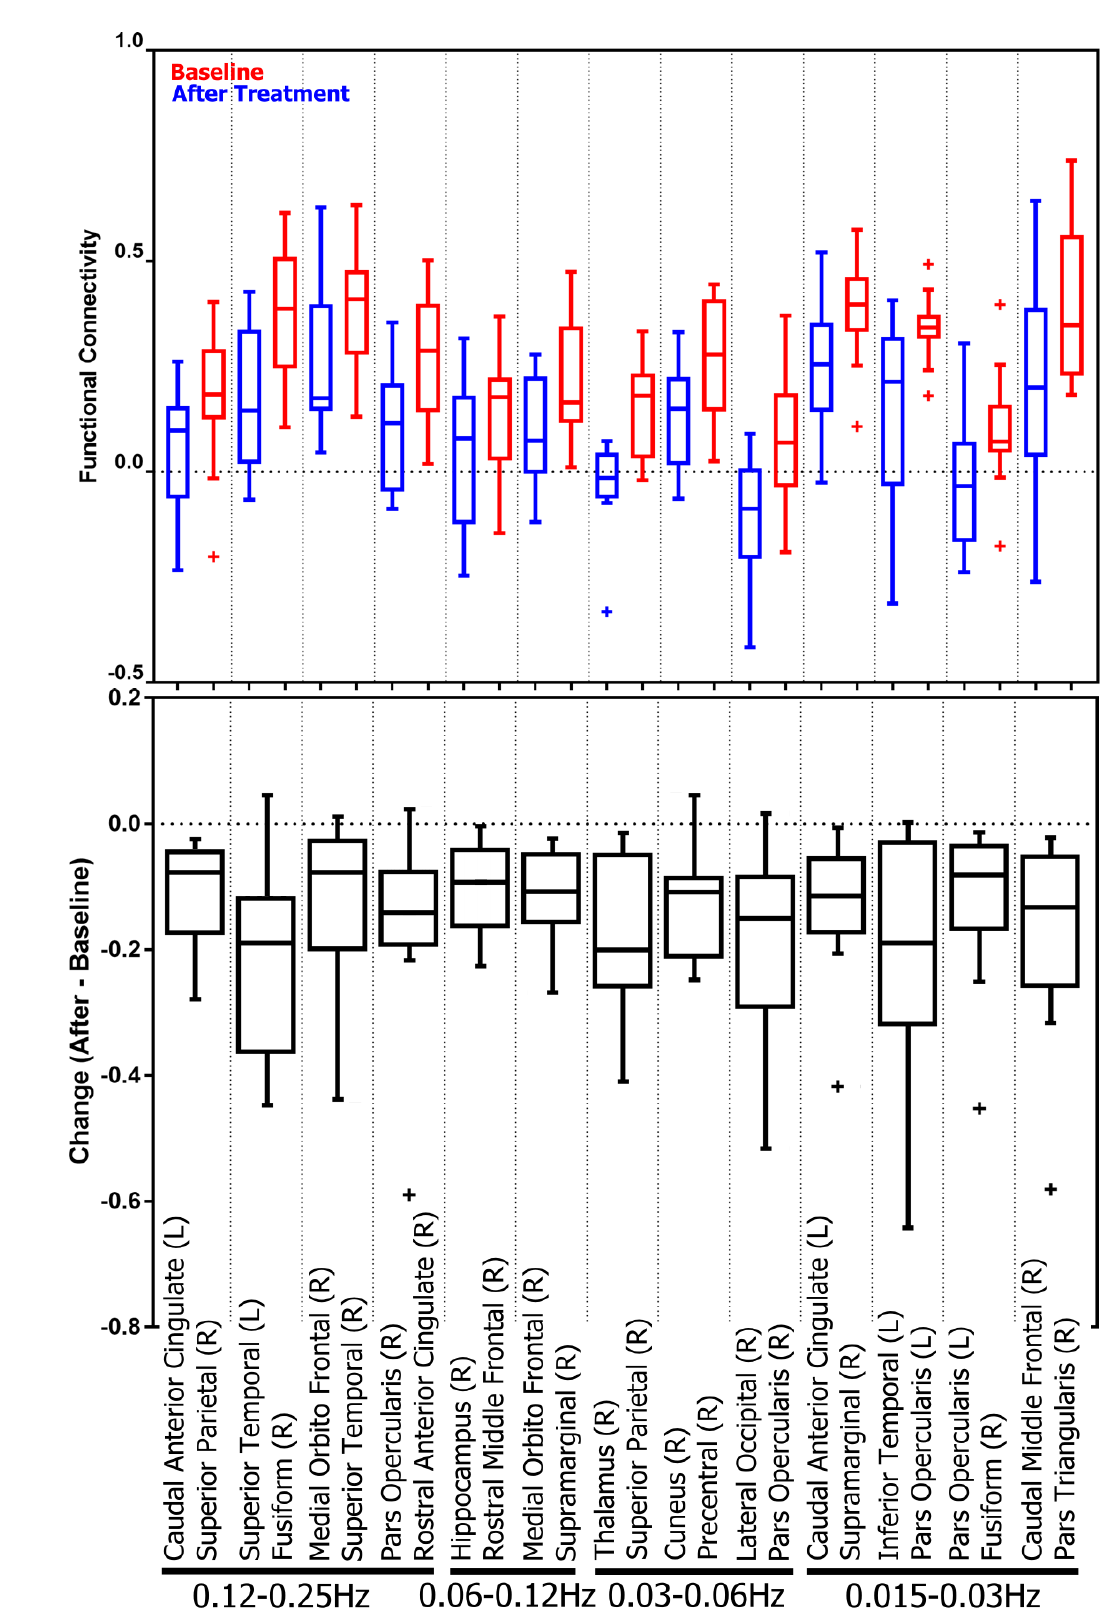
Figure 6. Boxplots for the functional connectivity of the altered connections. Top panel shows the distribution of the functional connectivity before and after the treatment, and the bottom panel shows the distribution of connectivity